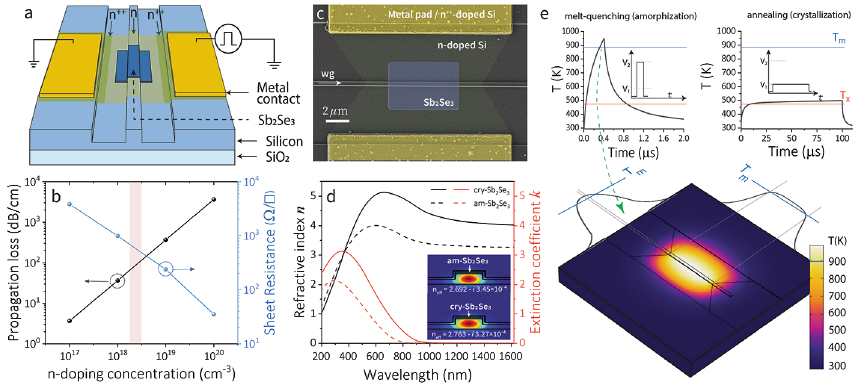
Fig. 1 Sb 2 Se 3 -based phase shifter using a doped-silicon microheater. a Microheater design with doped-silicon profiles to create an electrical resistor in a half-etched 220 nm SOI waveguide. b FEM simulated propagation loss and sheet resistivity as a function of phosphorous doping concentration. The highlighted region corresponds to the range where our proposed optimum doping concentration lies. c SEM image of a fabricated 6 μm-long bowtie microheater with a 6 μm-long Sb 2 Se 3 . d Sb 2 Se 3 refractive index in both amorphous and crystalline states with simulated optical modes for each state at 1565 nm wavelength. e FEM simulated transient temperature during and after the pulse excitation for both amorphization and crystallization. The three-dimensional (3D) plot shows the temperature profile at the end of the amorphization pulse, reaching the melting temperature of Sb 2 Se 3